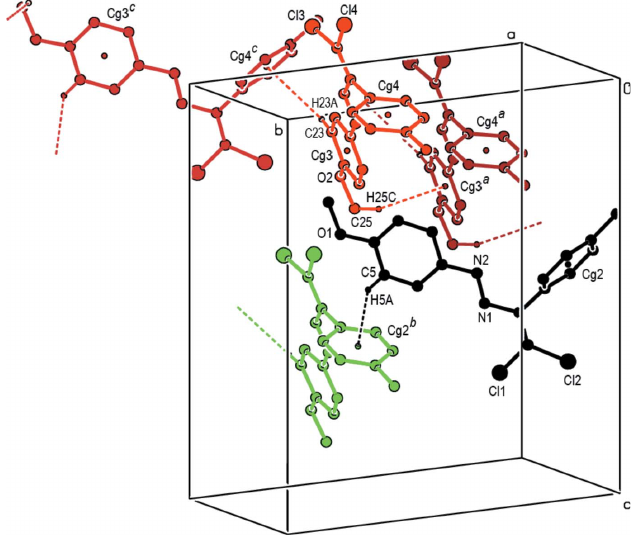
Figure 3 A general view of the C—H (cid:2)(cid:2)(cid:2) (cid:2) interactions in the title compound.